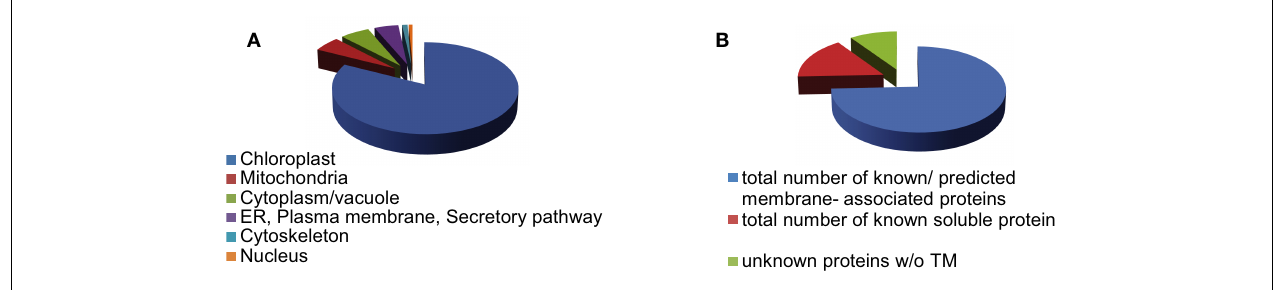
FIGURE 1 | Distribution of envelope proteins throughout different cell compartments (A) and by membrane association